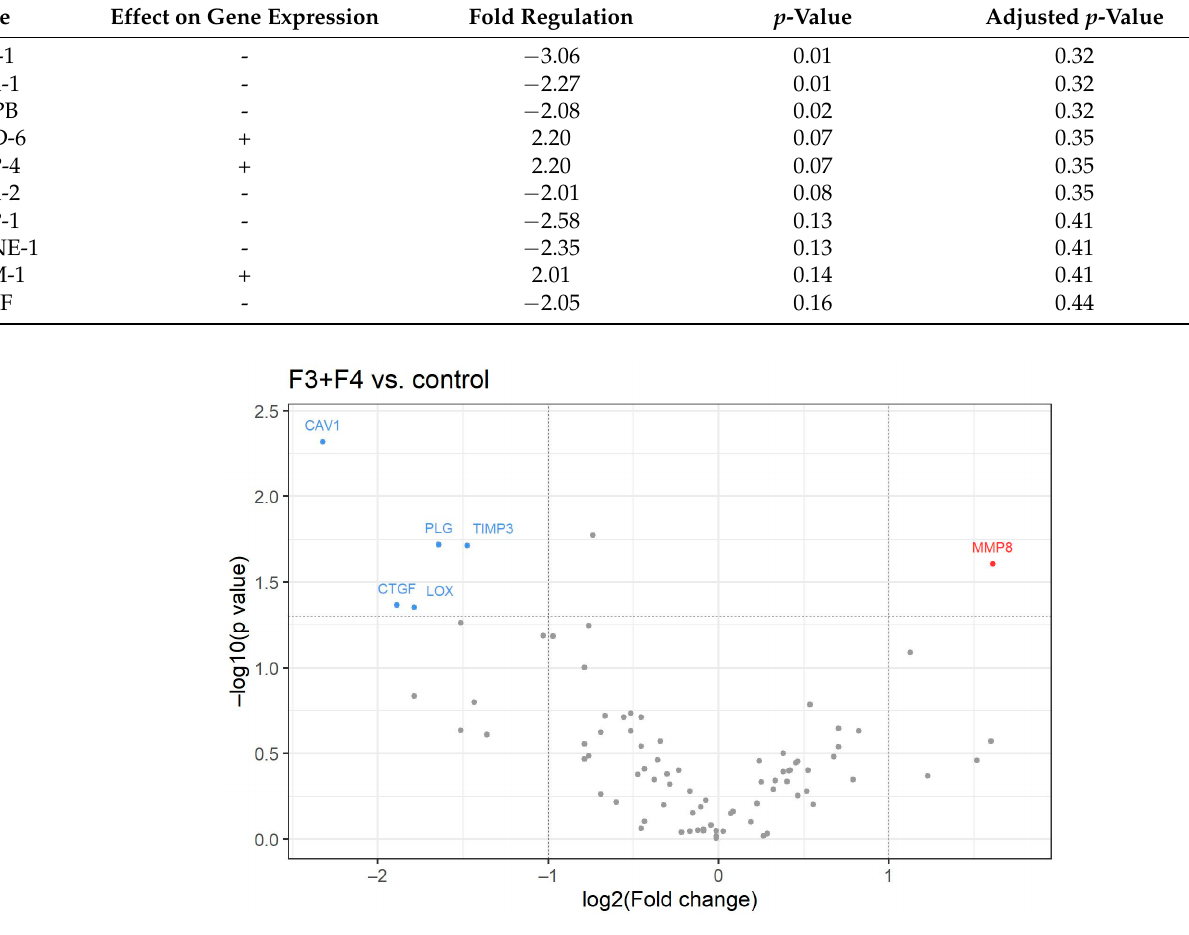
Figure 3. Volcano plot for 84 analyzed genes. The X-axis shows the log2 value of the fold change between patients with F3 and F4 stages of chronic hepatitis C compared to the healthy controls without HCV. The Y-axis represents − log10 p -value. Red points symbolize overexpressed genes and blue points represent underexpressed genes. Horizontal line shows threshold where p = 0.05. Table 4. Gene expression patterns in patients with chronic hepatitis C with mild fibrosis (F1/2) and controls. p -values were corrected for multiple testing with Benjamini–Hochberg method.